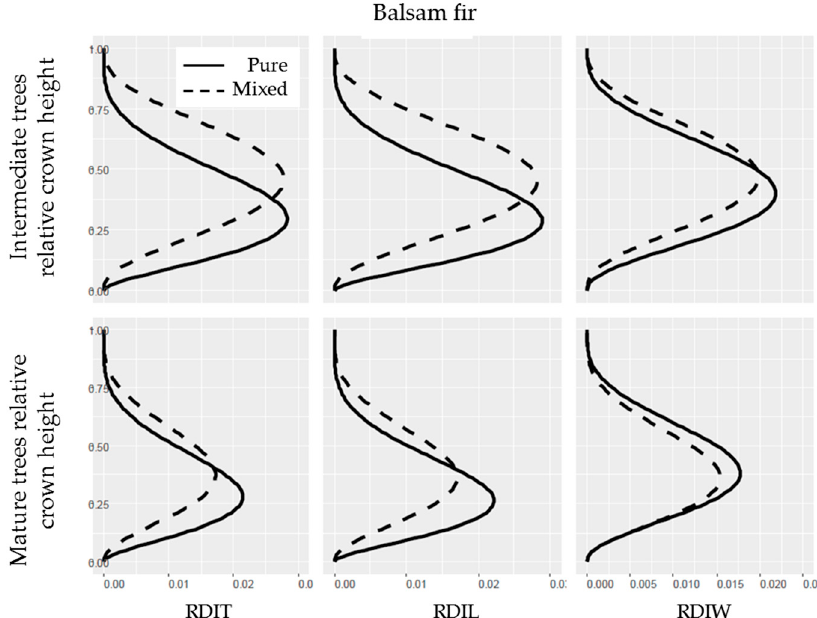
Figure 5. Mean beta distribution of balsam fir. The upper and lower parts show the distributions for intermediate and mature trees, respectively. Plain and dashed lines are respectively for trees in pure and mixed stands. From left to right: total relative density index (RDIT) profile, leaf relative density index (RDIL) profile and wood relative density (RDIW). A total of 36 balsam fir trees were used (9 per type of stand and developmental stage).